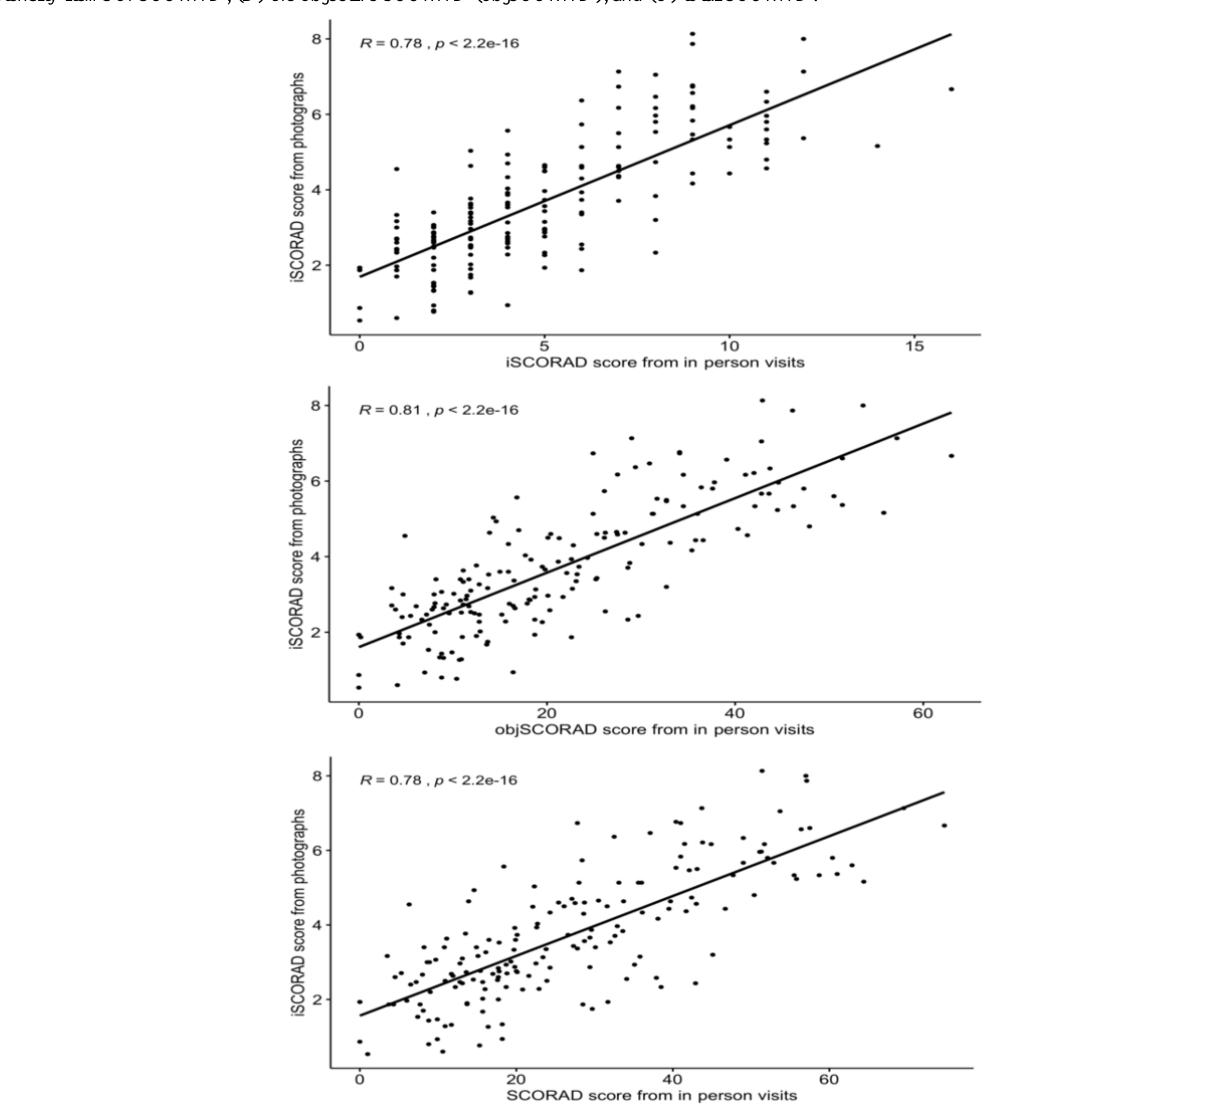
Figure 1. Correlation between the intensity items of Scoring AD (iSCORAD; 0-18) assessed from photos and in-person assessments based on (A) the intensity items of SCORAD, (B) the objective SCORAD (objSCORAD), and (C) total